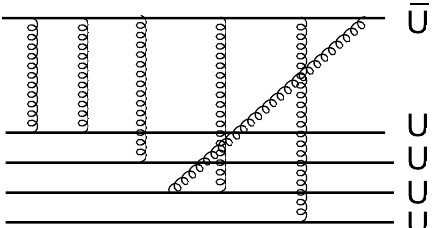
Figure 5. A representative diagram for scattering of a single projectile gluon in the dense-dilute limit. Here we have drawn the projectile gluon on the top of the (cid:12)gure and the target gluons at the bottom.